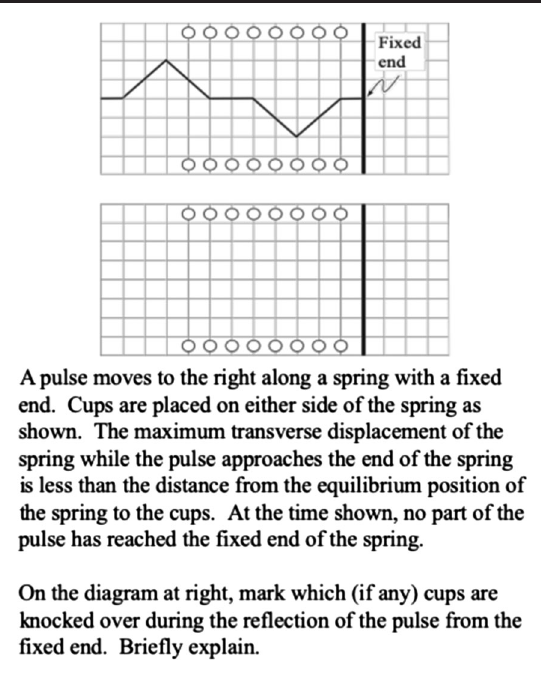
FIG. 7. The predict-style question for reflection (the cups question). This question was modified from Kryjevskaia, Stetzer, and Heron